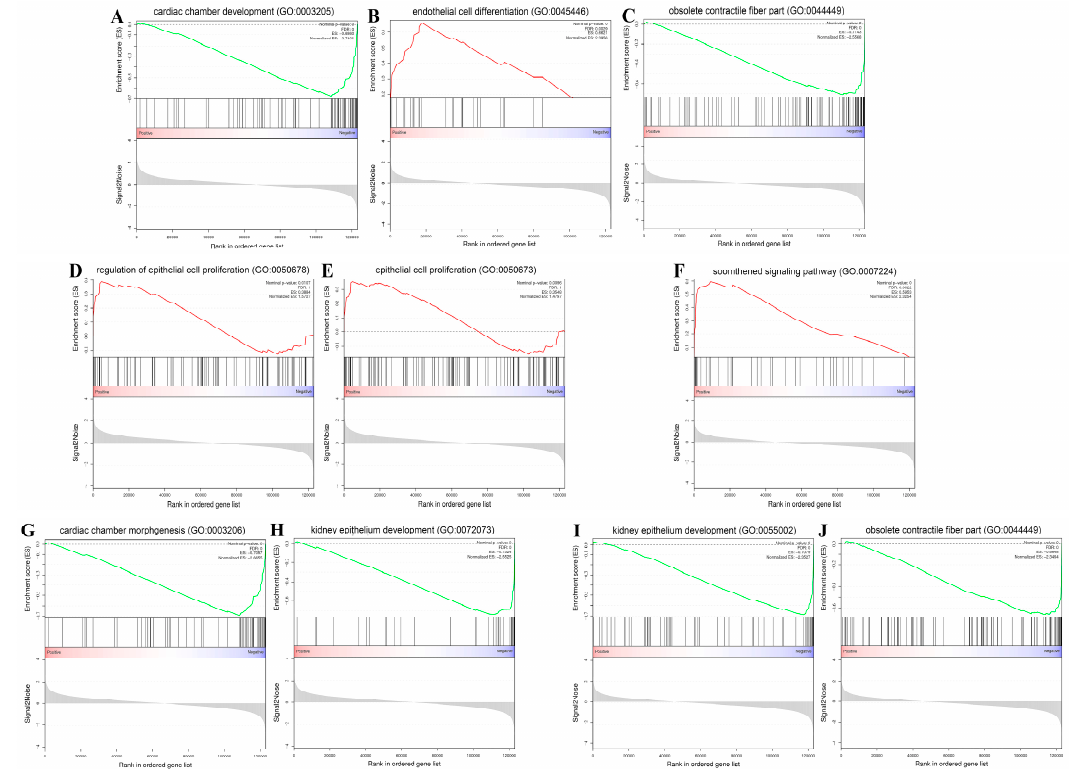
Figure 3. Significant enrichment of gene ontology (GO) plots based on gene set enrichment analysis (GSEA). ( A – C ) GO plots of the most significantly enriched gene sets in CrTK14 vs. CrTK15, CrTK15 vs. CrTK16 and CrTK14 vs. CrTK16 groups. ( D , E ) “Epithelial cell proliferation” and “regulation of epithelial cell proliferation” were significantly enriched in CrTK14 vs. CrTK15. ( F ) “Smoothened signaling pathway” was significantly enriched in CrTK15 vs. CrTK16. ( G , H ) The top 2 negative enrichment in CrTK14 vs. CrTK15. ( I , J ) The top 2 negative enrichment in CrTK15 vs.